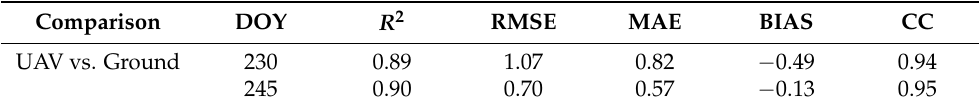
Table 7. Statistical performance of the UAV with ground measurements. Comparison